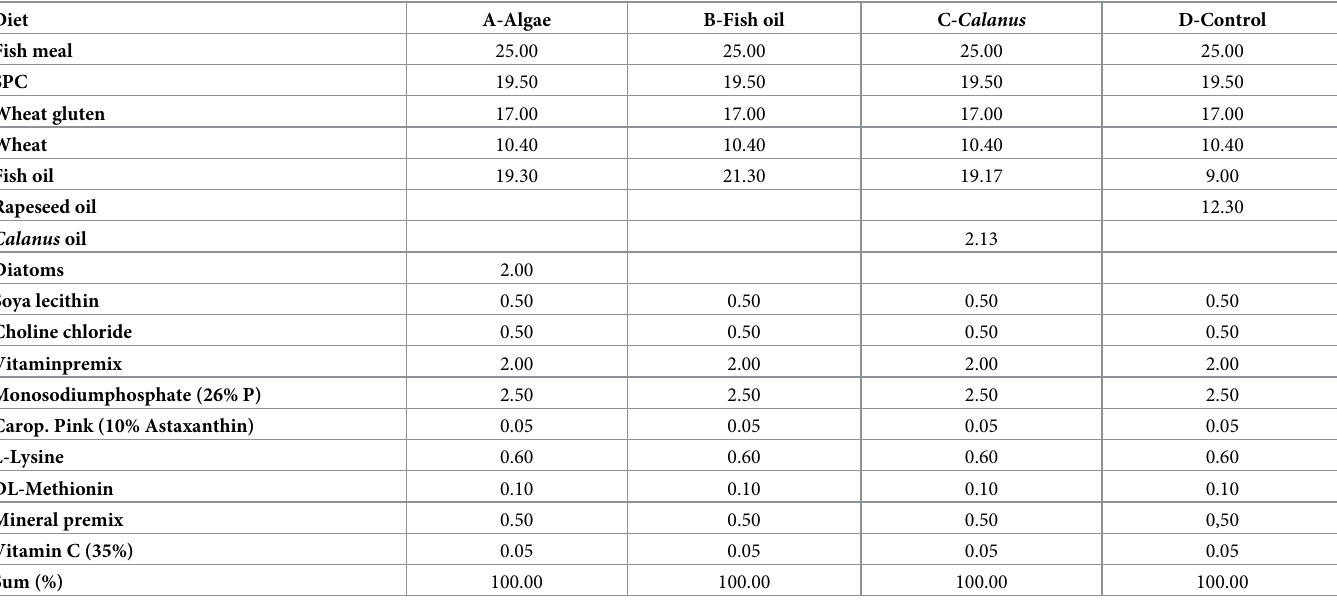
Table 1. Ingredient composition in the four feed types, % of dry weight.